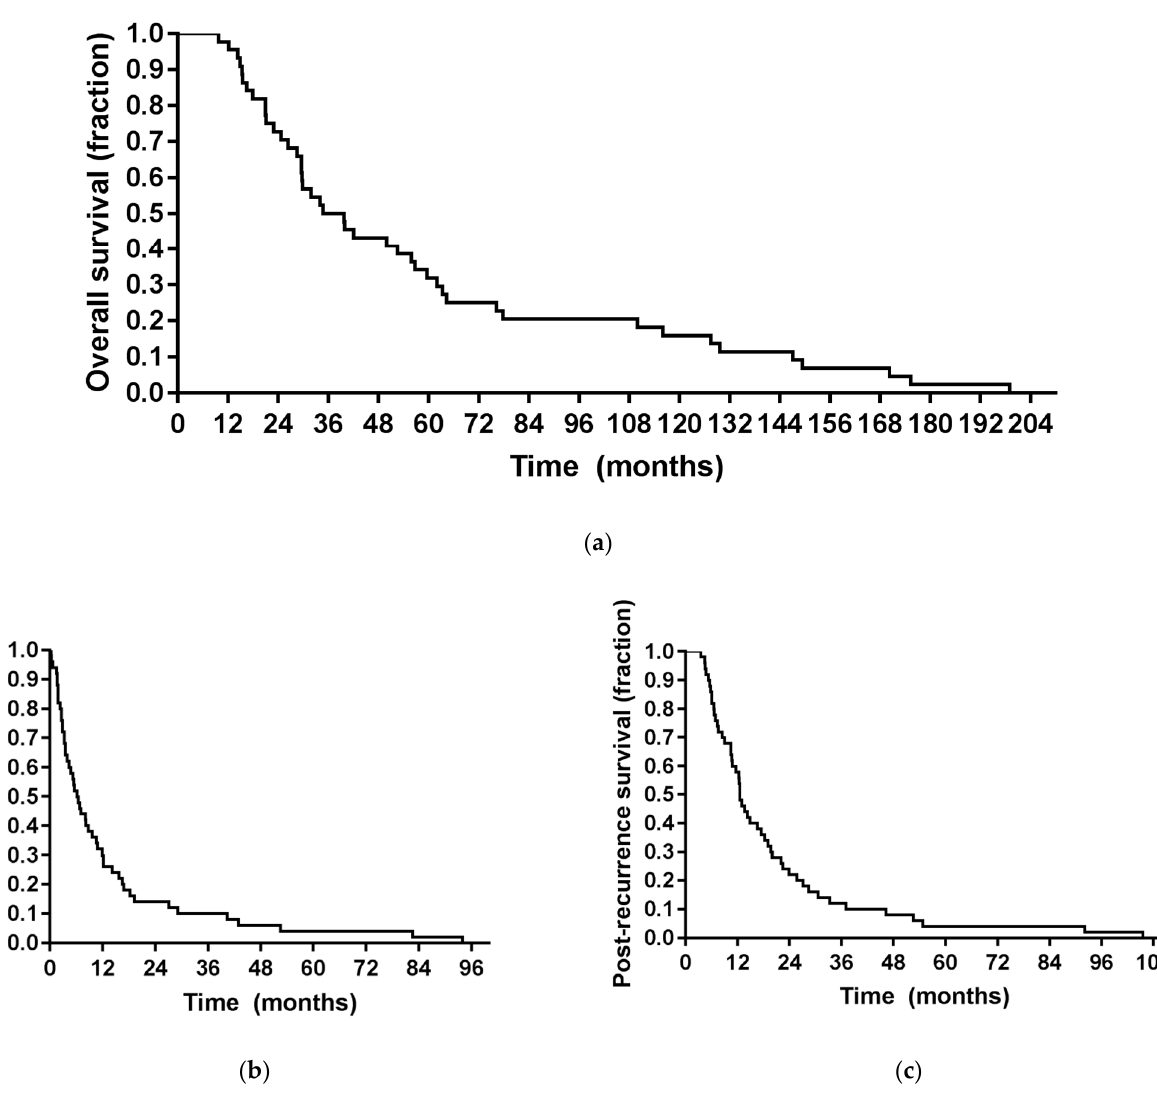
Figure 2. Survival curves. ( a ) Overall survival of the study population after initial tumor diagnosis; ( b ) time-to-treatment failure (TTF) of the study population after iPDT treatment; ( c ) post-recurrence survival (PRS) of the study population after iPDT treatment.